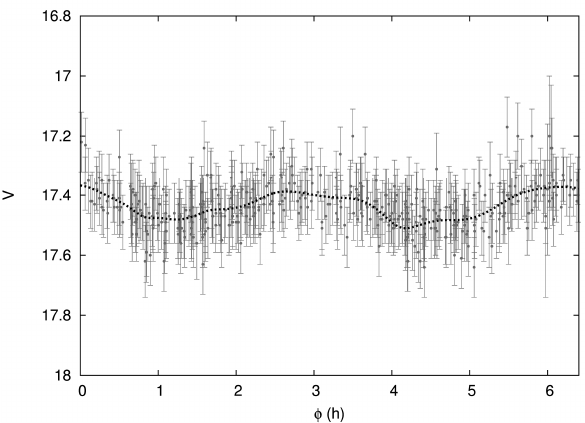
Figure 12. CSS light curve for SDSS J120616.93+115936.2, phase- folded to the 6.4 h, which is the same obtained analysing the ve- locities, suggesting the variability is due to either eclipses or ellip- soidal